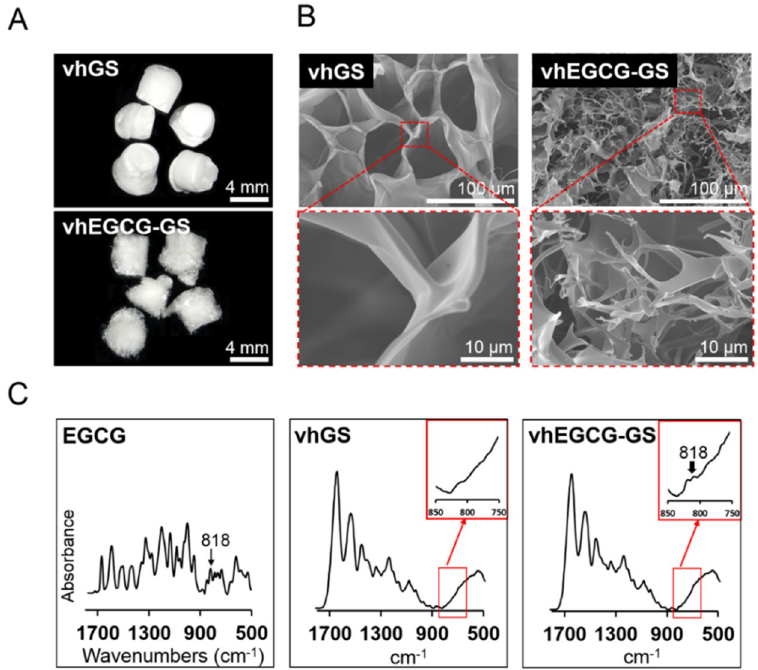
Figure 3. Characterization of the prepared sponges. ( A ) Macroscopic images and ( B ) scanning electron microscopy (SEM) images of the sponges. ( C ) Fourier transform infrared (FTIR) spectra of the sponges and EGCG.